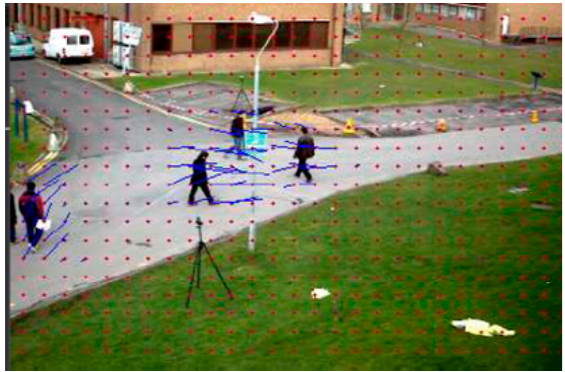
Figure 2. Motion detection through optical flow.